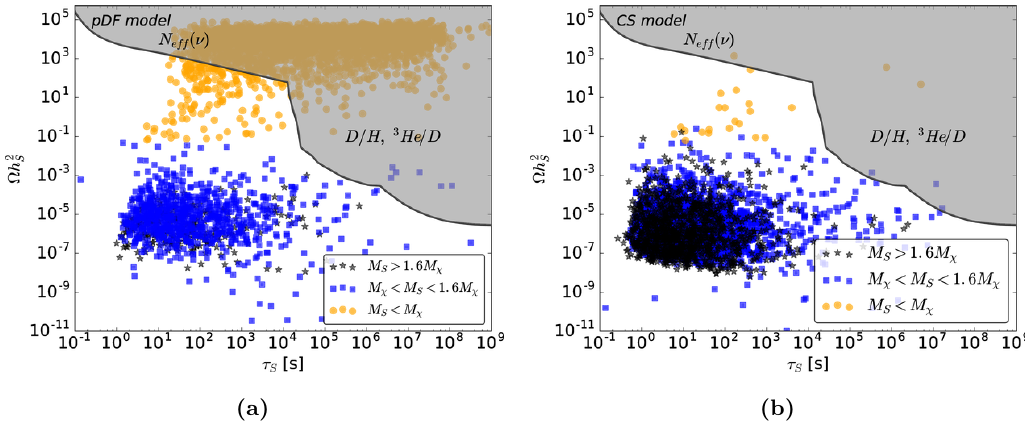
Figure 8. Constraints from light element abundances and from the e(cid:11)ective number of neutrinos on the lifetime of the dark Higgs boson (cid:28) S and on its metastable relic density after freeze-out. In order to allow simple comparison with the dark matter relic density, we show the relic density (cid:10) h 2 the dark Higgs boson would have had today if it was stable. Points satisfying the dark matter relic density constraint are overlaid for the pDF model (a) and for the CS case (b) . The points have been sorted according to the mass range of the dark Higgs boson. Notice that CMB-related bounds are not included, which explain why points with M S < M (cid:31) remain in the CS case. injection of electrons from S decay. The e(cid:11)ect it can have on BBN can be constrained using the PLANCK measured value of N e(cid:11) . The de(cid:12)nition of e(cid:11)ective number of neutrino species assumes that the three neutrino species instantaneously decouple giving a